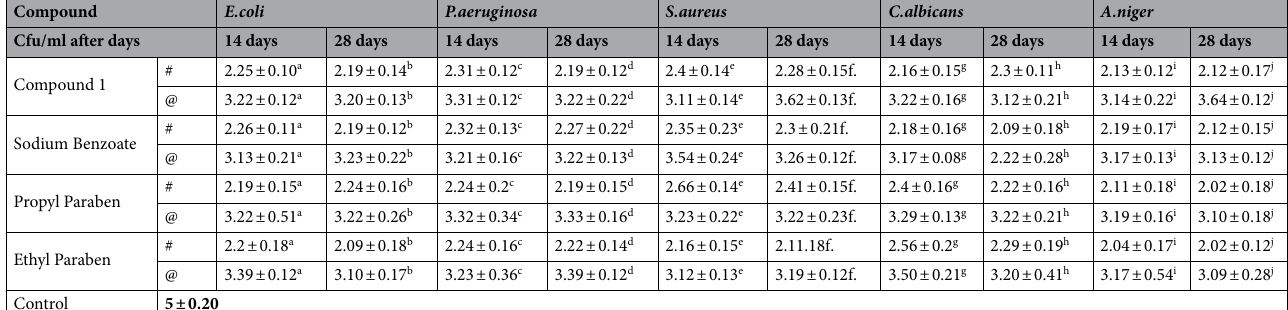
Table 2. Log CFU/ml values of the selected compound 1 in Aloe vera juice and White lotion USP. # Aloe vera